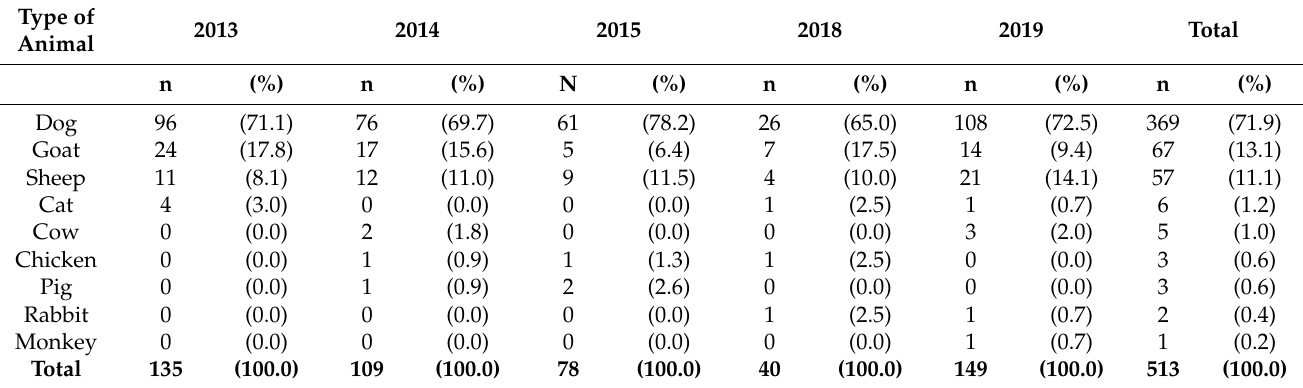
Table 1. Number and type of animals that received veterinary care at the Kintampo Municipal Veterinary Clinic in Ghana stratified by year,